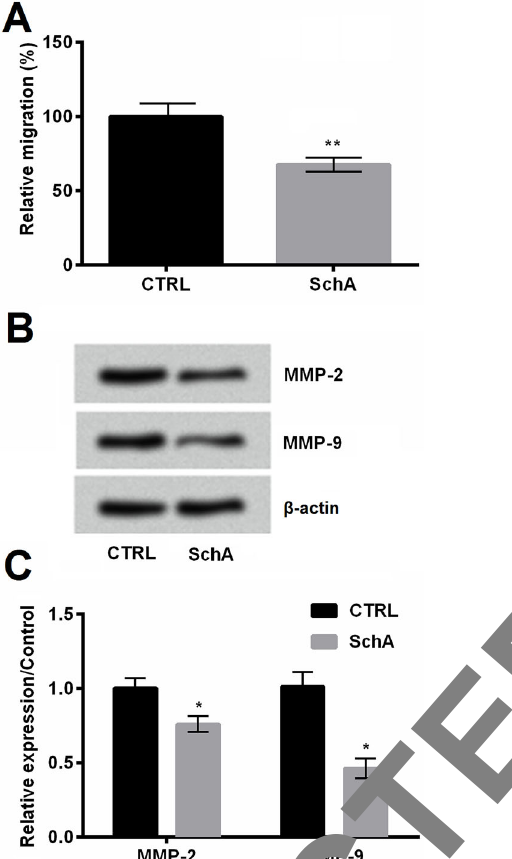
Figure 3. Schizandrin A (SchA) decreased cell migration. A , Cell migration was detected by transwell two-chamber assay. B , MMP-2 and MMP-9 protein levels were determined by western blot. C , Levels of MMP-2 and MMP-9 were analyzed quantita- tively. b -actin was used as control. Data are reported as means ± SD (n=3). *P o 0.05 and **P o 0.01 compared to control (Student ’ s t